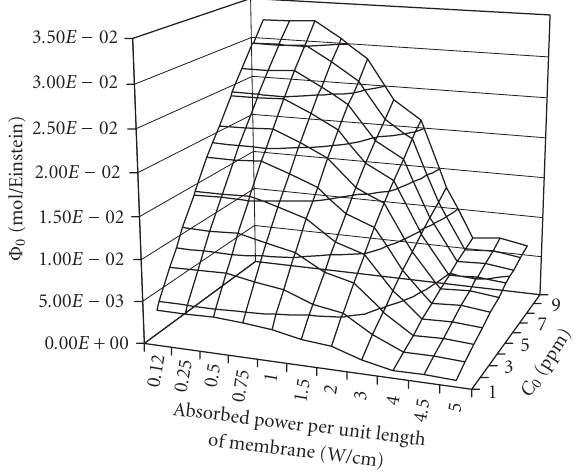
Figure 8: Quantum yields Φ 0 (mol of methanoic acid/Einstein) as a function of initial concentration C 0 expressed as ppm (mass/vol ume) of carbon and of absorbed power per unit length of lamp (and membrane) expressed as Wcm − 1 .